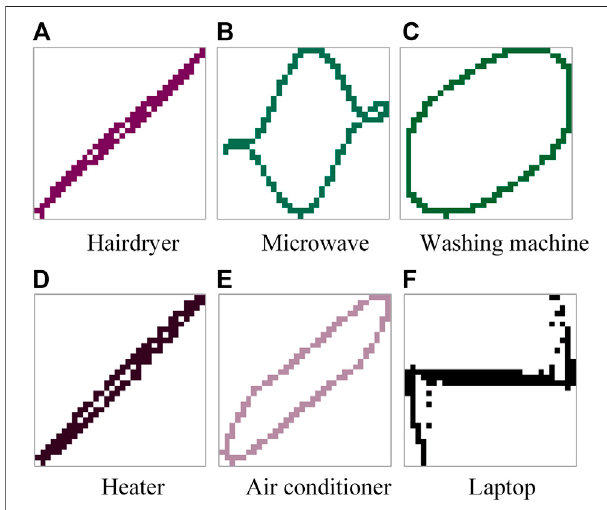
FIGURE 3 | True-color feature image.